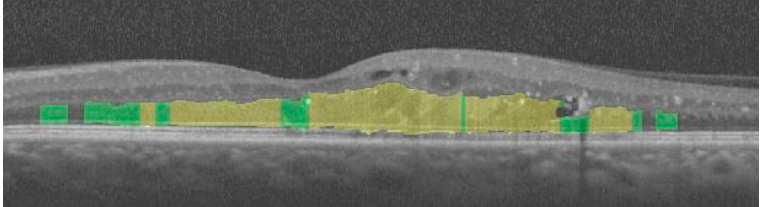
Figure 2. Illustrative output OCT image after the application of the second post-processing approach. Yellow regions, direct results from the classifier. Green regions, results of the second post-processing